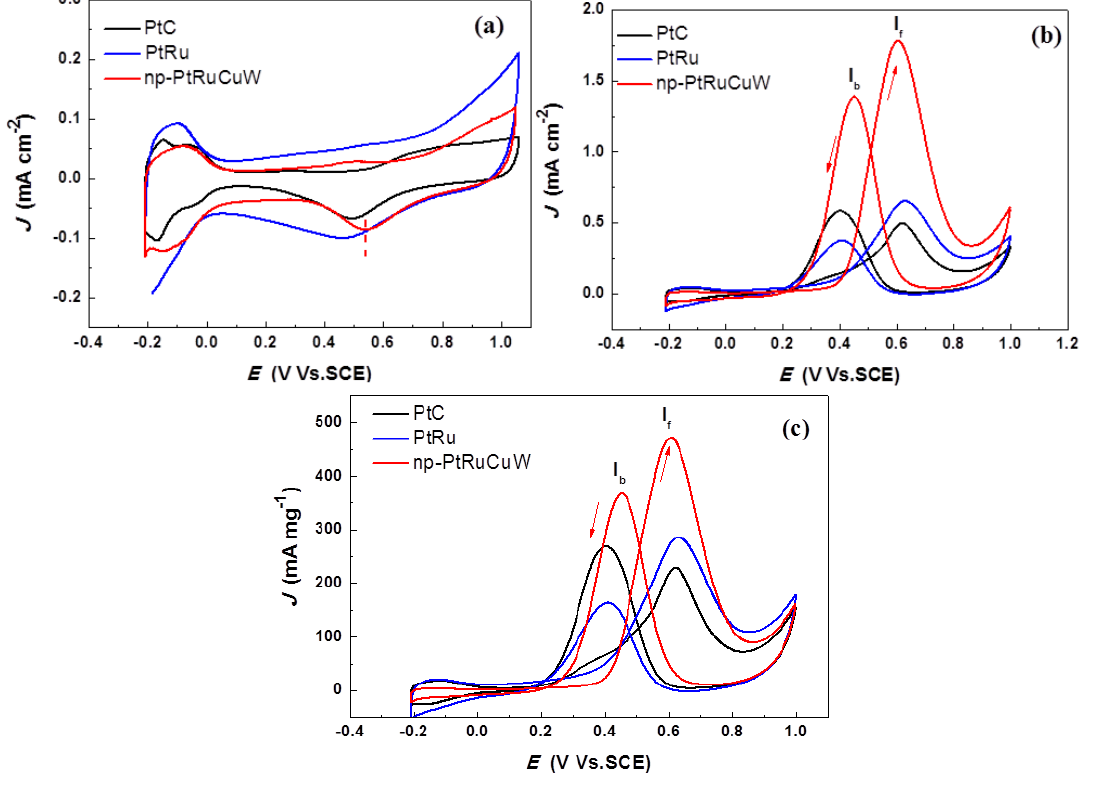
Figure 3. ( a ) The stable CVs of the np-PtRuCuW, PtC and PtRu catalysts in the N 2 purged 0.5 M H 2 SO 4 solution (Scan rate: 50 mV s − 1 ); and ( b ) ECSA- and ( c ) mass-normalized activities of the np-PtRuCuW, PtC and PtRu catalysts for methanol oxidation. (Scan rate: 50 mV s − 1